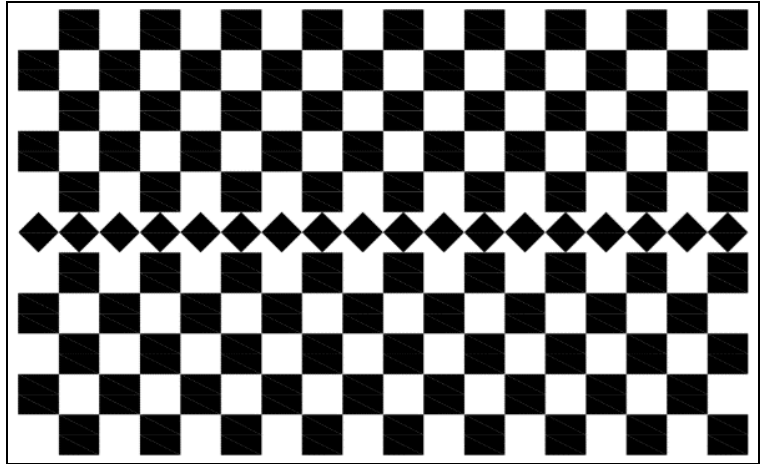
Figure 4. The proposed calibration board.